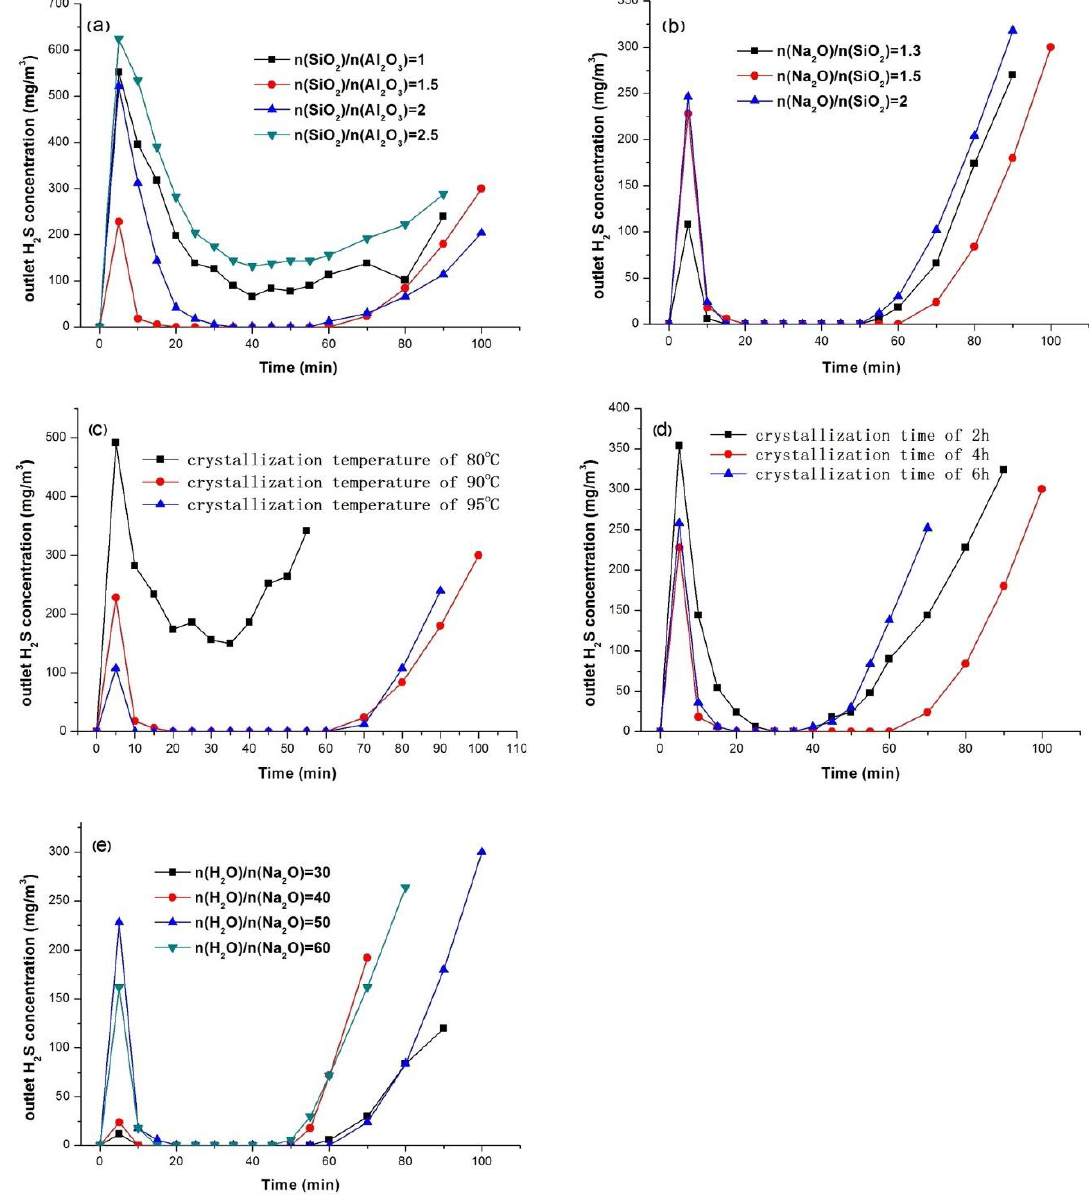
Figure 4. H 2 S adsorption breakthrough curves at 25 °C under different synthesis conditions: ( a ) at various (SiO 2 )/n (Al 2 O 3 ) ratios ( b ) at various (Na 2 O)/n (SiO 2 ) ratios, ( c ) at various temperatures, ( d ) at various crystallization time, ( e ) at various (H 2 O)/n (Na 2 O) ratios, reprinted from [57], with permission of Elsevier.